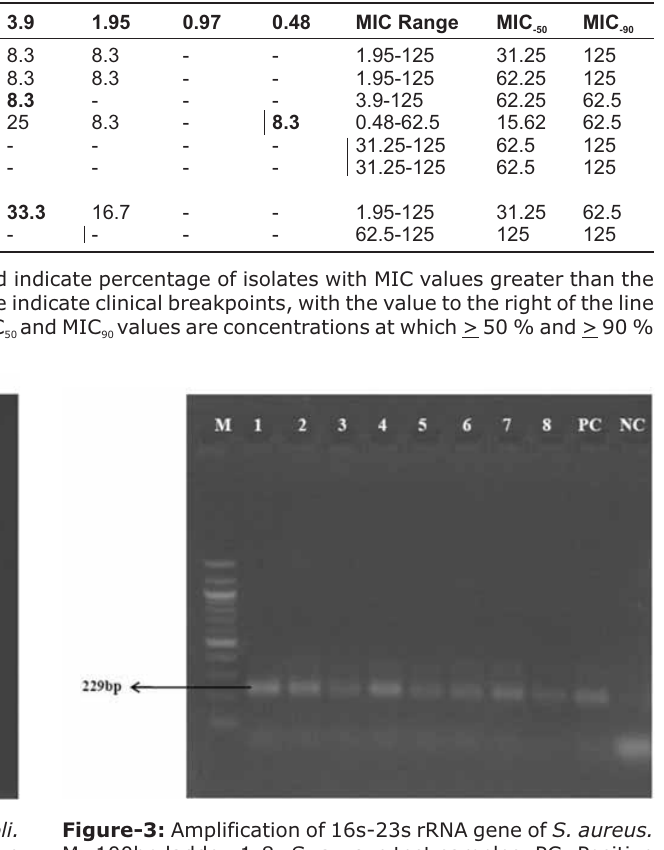
Confirmation of the mastitis bacteria by targeting specific genes for different strains: